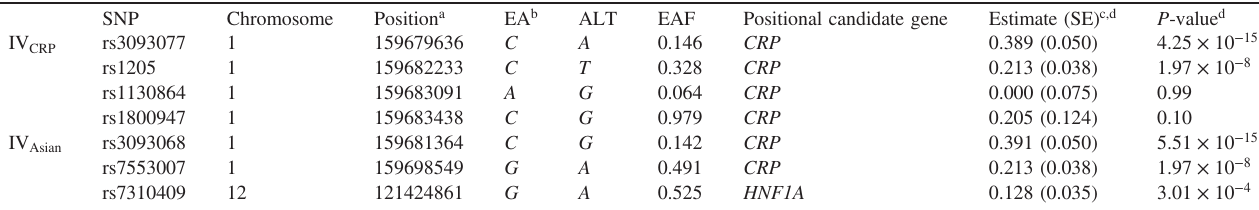
Table 2. The SNP list for the two di ff erent instrumental variables (IV CRP and IV Asian )